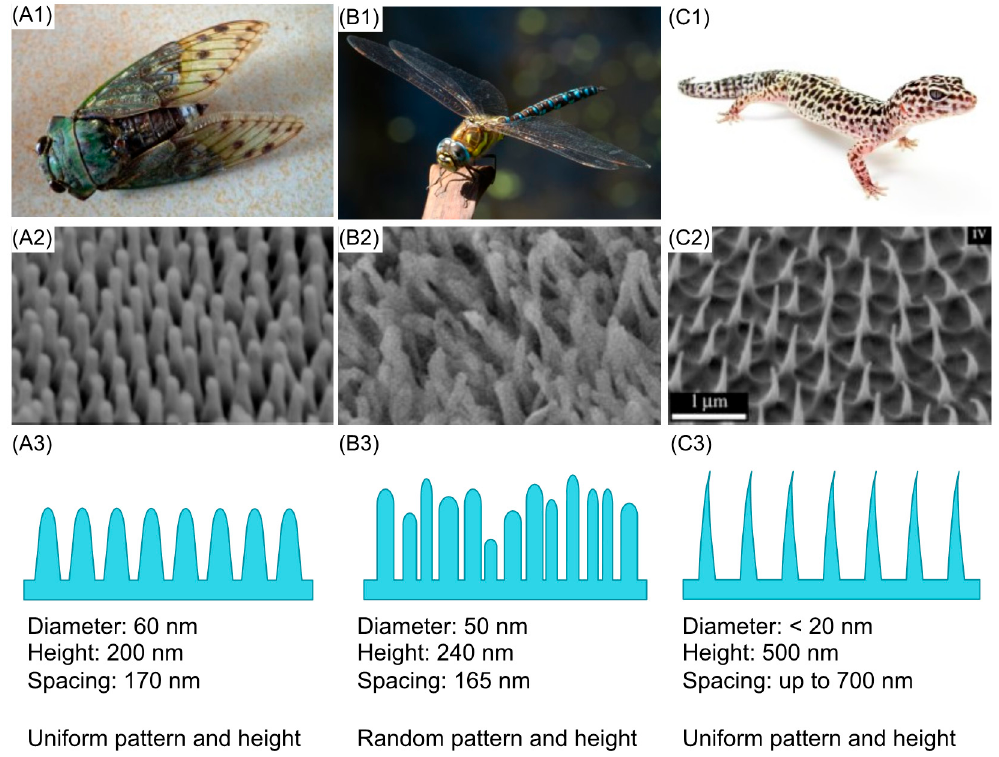
Figure 1. Naturally occurring mechano-bactericidal surfaces: ( A1 – C1 ) Cicada, dragonfly and gecko, respectively; ( A2 – C2 ) Scanning electron microscopy (SEM) images of cicada wing, dragonfly wing and gecko skin; ( A3 – C3 ) Schematic of the representative nanotopographies found on the cicada wing, dragonfly wing and gecko skin to highlight the differences between each nanotopography.